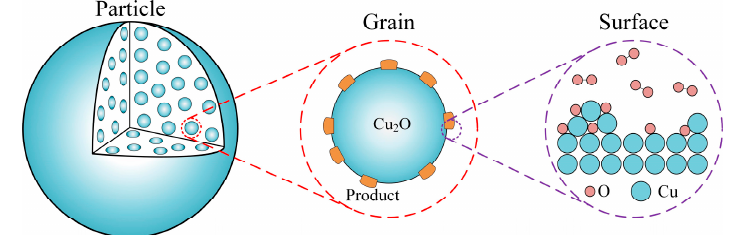
Figure 1. Schematic diagram of the multiscale model.